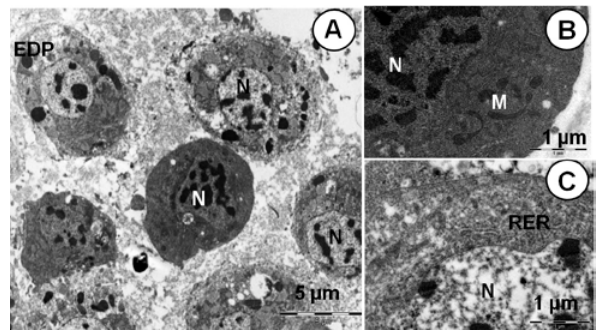
Figure 2. Transmission electron microscopy (TEM) of hemocytes of control fifth instar larvae of B. mori (A) showed smooth plasma membrane, clear cytoplasm and cells with few granules and elec- tron dense particles (EDP), nucleus (N) with oval or branched nuclear membrane and evenly distributed chromatin, several mito- chondria (M) with developed cristae (B) and rough endoplasmic reticulum (RER) (C).